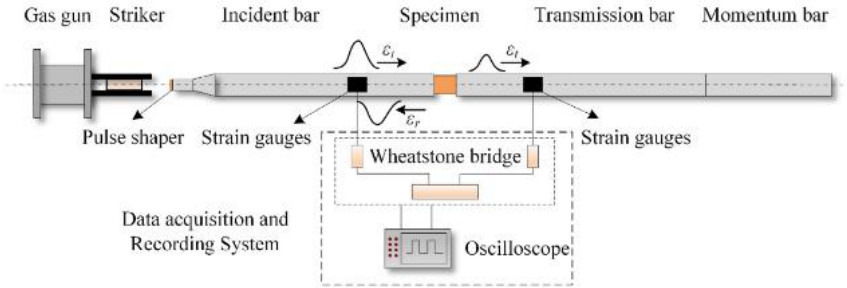
Figure 20. Split Hopkinson pressure bar system (reprinted from Ref. [85]).